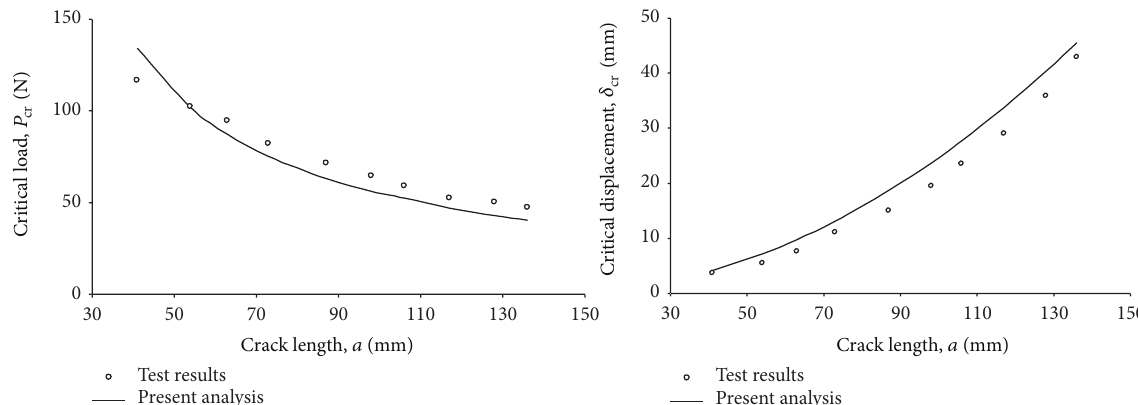
) and the corresponding displacement (𝛿 ) cr cr